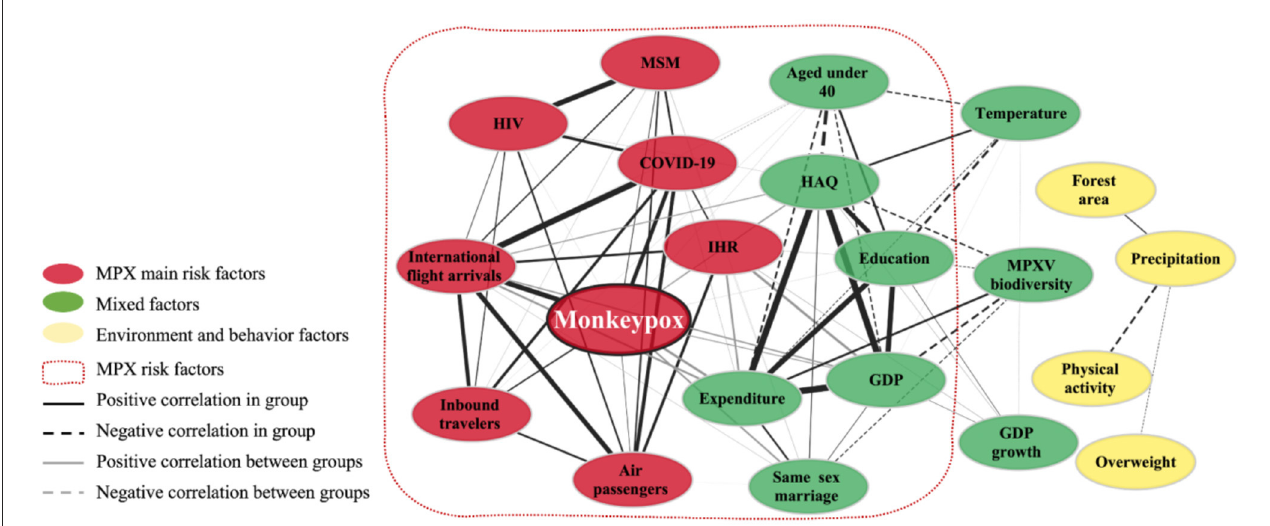
FIGURE2 Risk factors associated with MPX infection in imported countries in 2022. Risk factors potentially affecting the 2022 outbreak were classified into three groups (colored ellipses). Red nodes are main risk factors. Green nodes are mixed factors. Yellow nodes are environment and behavior factors. Significant pairs identified by the Spearman correlation test (coefficient r < 0.3, p < 0.05) are connected by edges with the width representing the significance [–log10( p -value)]. MPX, monkeypox infections; GDP, gross domestic product per capita; MSM, men who have sex with men; MPXV, monkeypox virus;